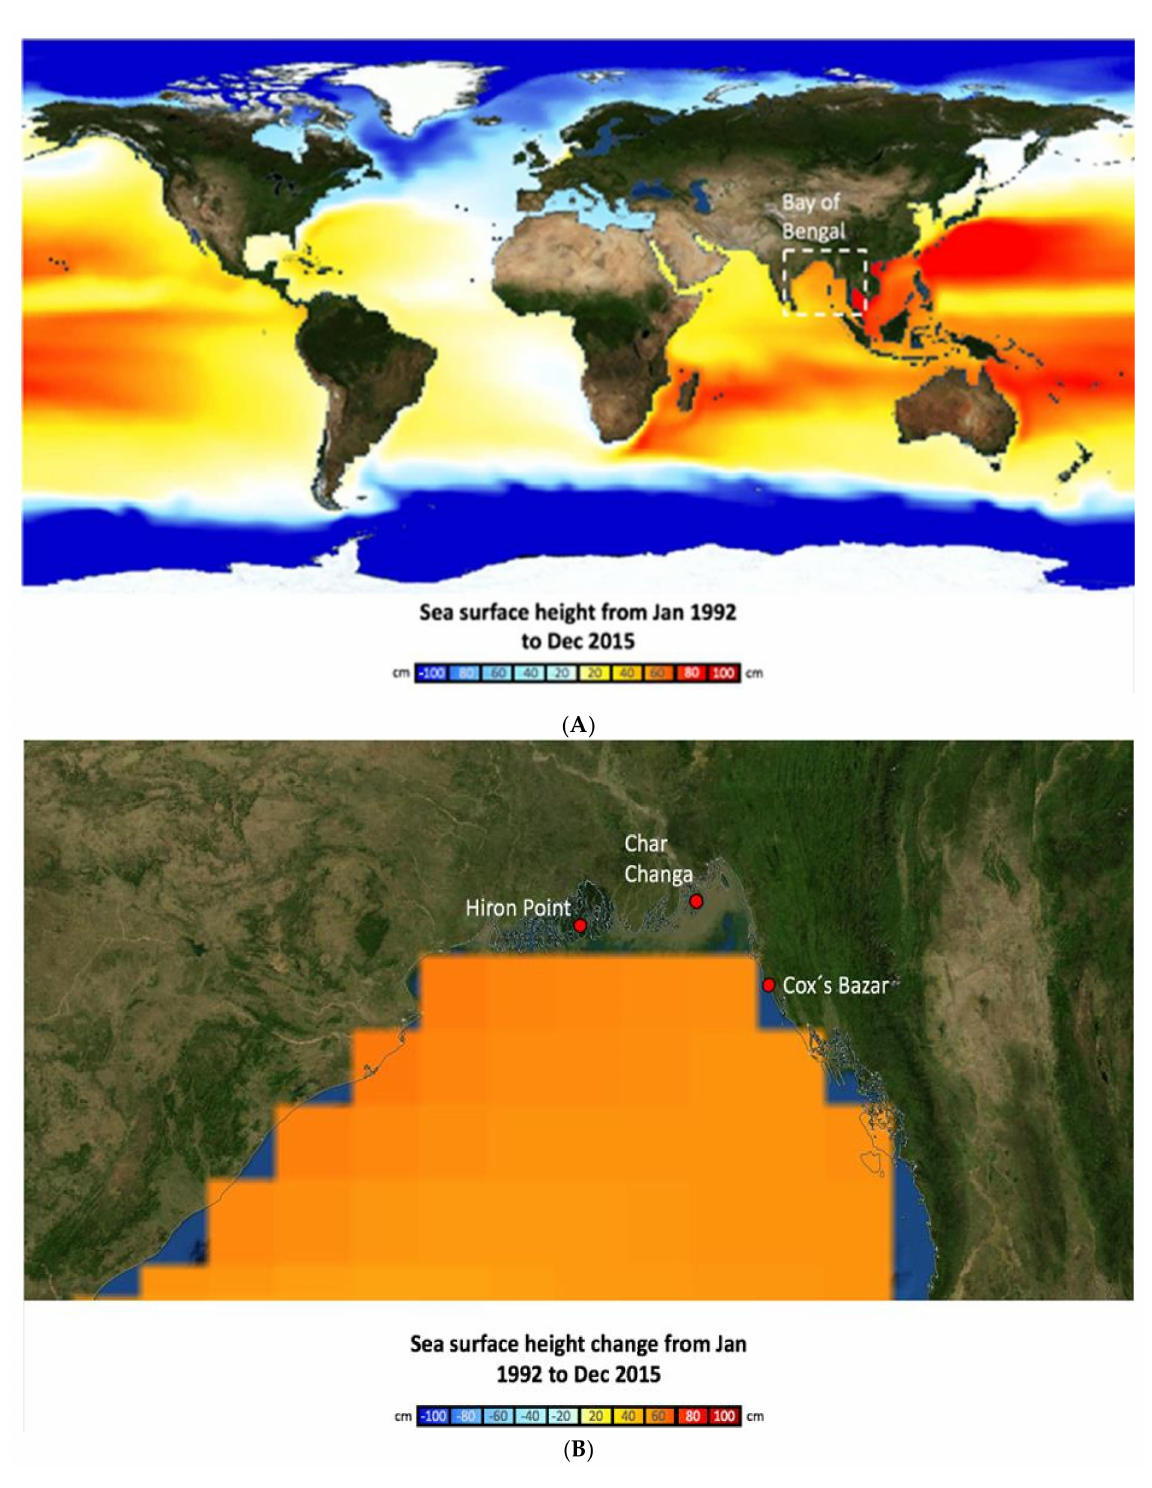
Figure 4. Sea level changes from 1992 to 2015 with the global pattern ( A ) and RSLR from the southern Bay of Bengal region ( B ). High latitudes show a decrease in sea level rise, which can be attributed to the lowering of gravitational attraction due to the loss of glacial mass. Data retrieved from JPL ECCO server (2020)